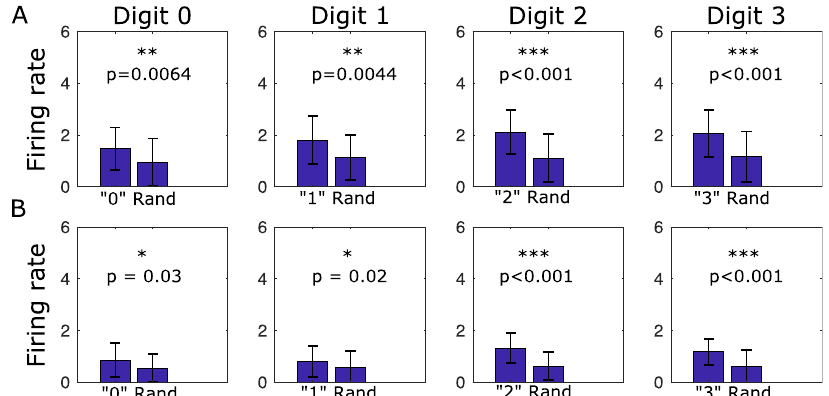
Fig. 6 | Task-speci fi c neurons are more likely to be activated during sleep. Spiking activity of digit-speci fi c neurons during sleep is greater than activity of a randomsubsetofneuronsinboth fi rst( A )andsecond( B )hiddenlayers.Neuronsare